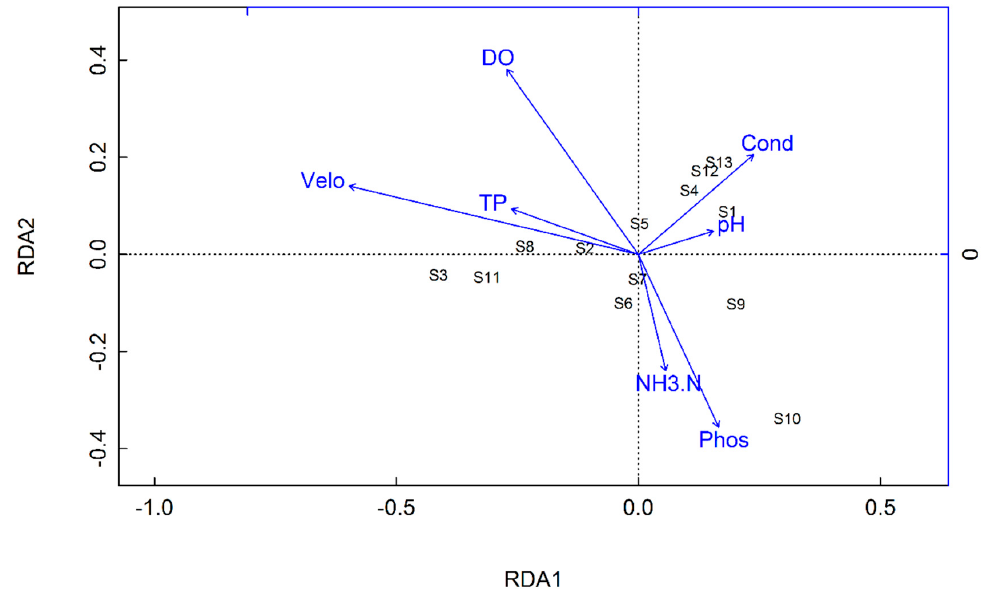
Figure 4. Ordination diagram of redundancy analysis (RDA) based on benthic diatom communities and environmental factors.